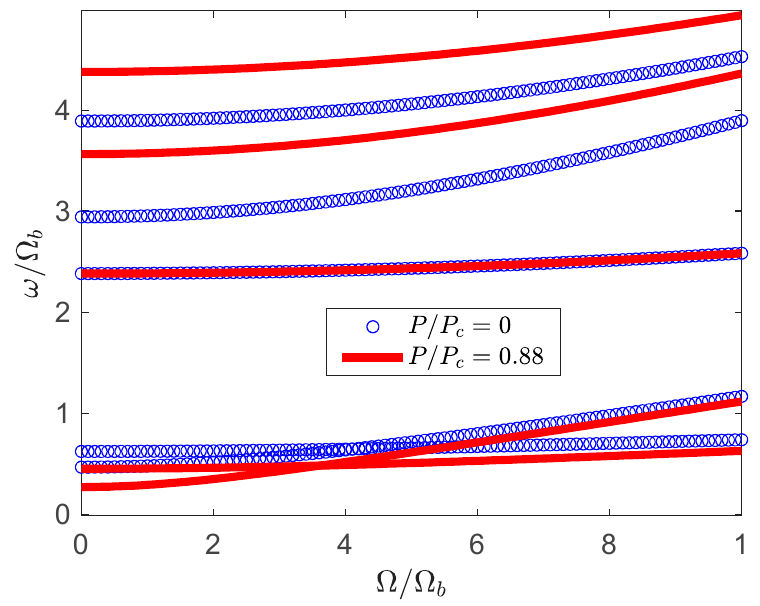
Figure 4. The effect of axial force on the rotating frequencies of the composite blade for θ = 0 o .